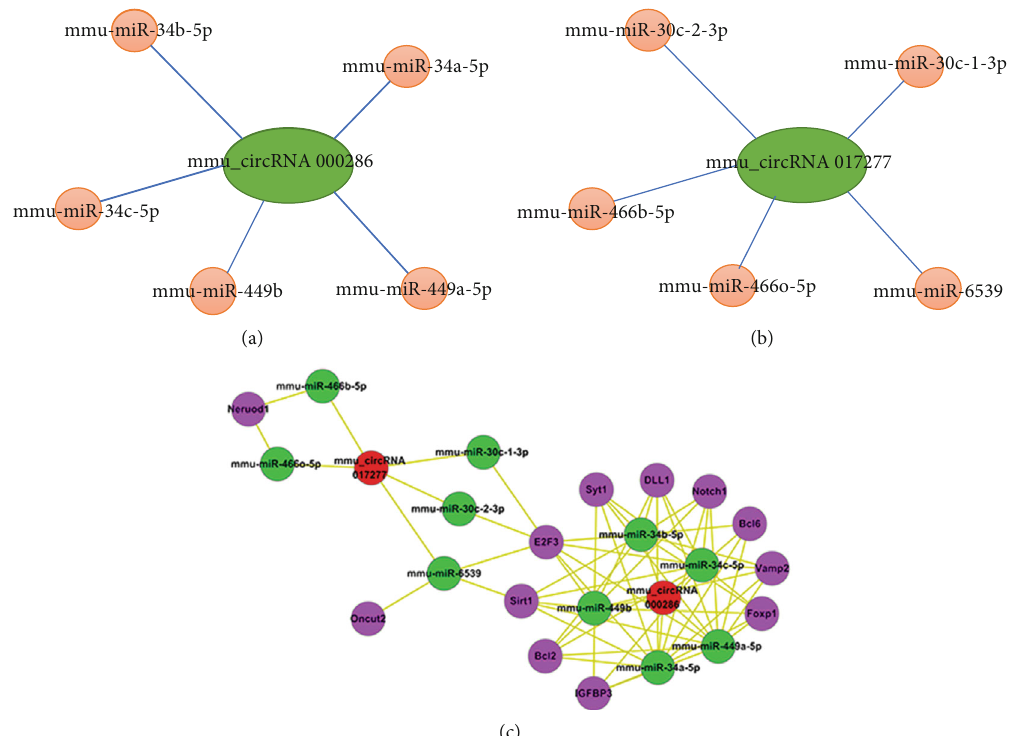
Figure 5: Construction of the speci fi c circRNA-miRNA-mRNA ceRNA regulatory network for circRNAs 000286 and 017277. Predicted miRNAs that may interact with circRNA 000286 (a) and 017277 (b). Green circles represent the selected circRNAs. Orange circles represent the predicted miRNAs. (c) The speci fi c circRNA-miRNA-mRNA ceRNA regulatory network for circRNAs 000286 and 017277. Red circles represent the selected circRNAs. Green circles represent the predicted miRNAs. Purple circles represent the predicted